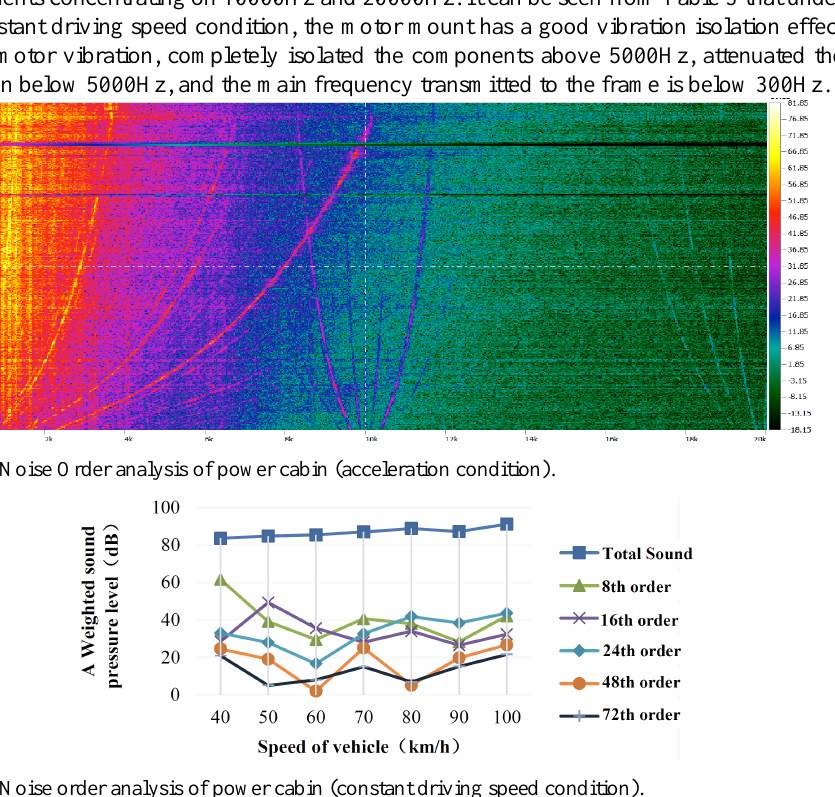
Fig. 14. Noise order analysis of power cabin (constant driving speed